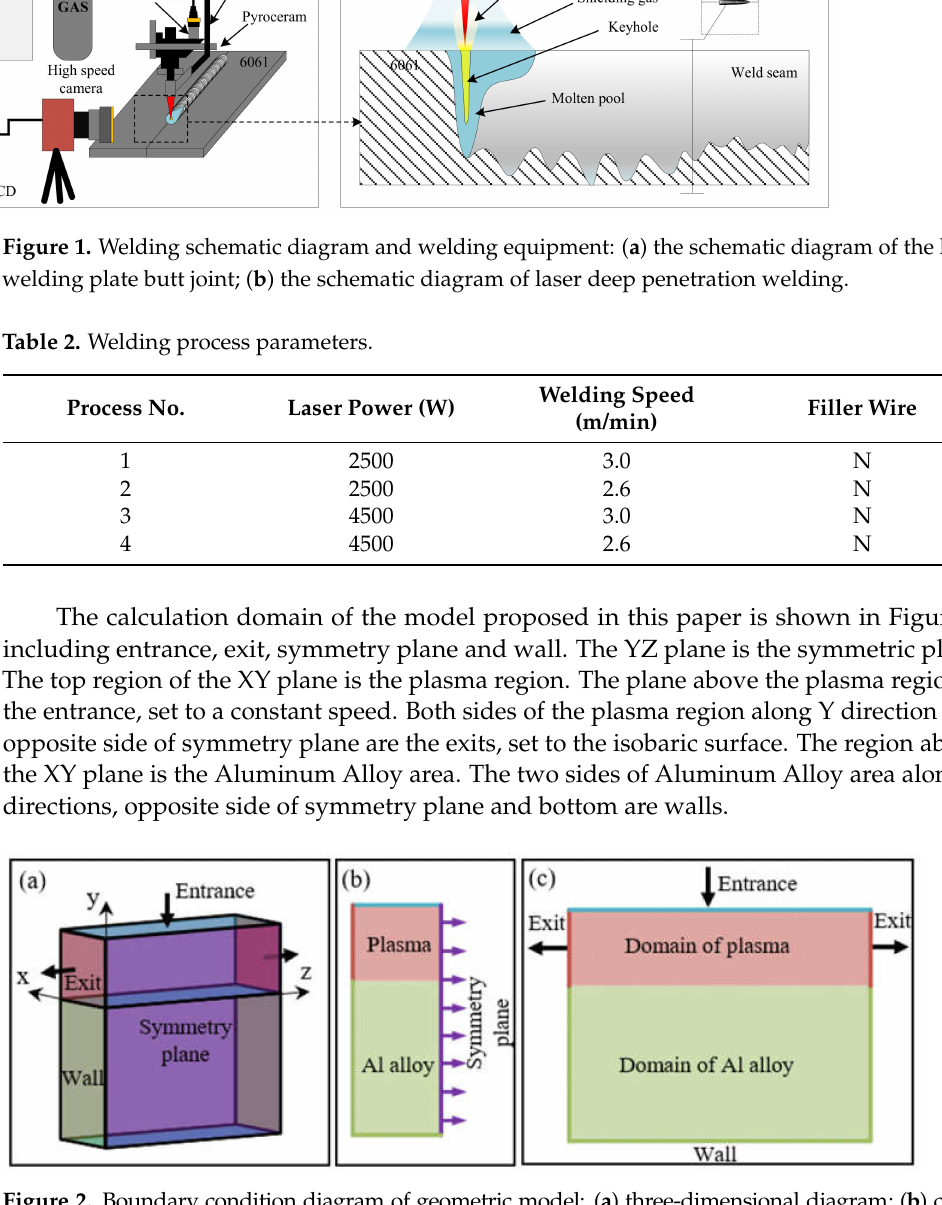
Figure 2. Boundary condition diagram of geometric model: ( a ) three-dimensional diagram; ( b ) cross- section; ( c ) longitudinal